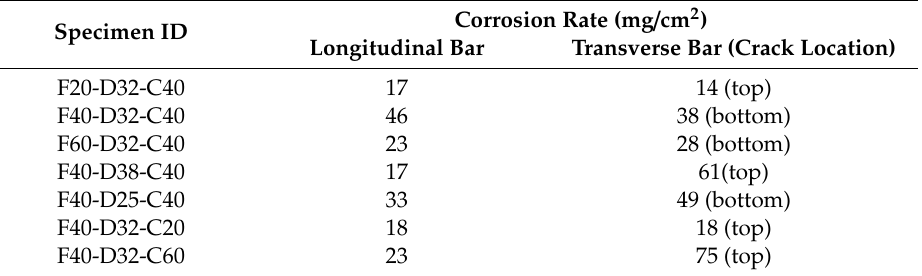
Table 4. Corrosion rate and crack width at the time of the first